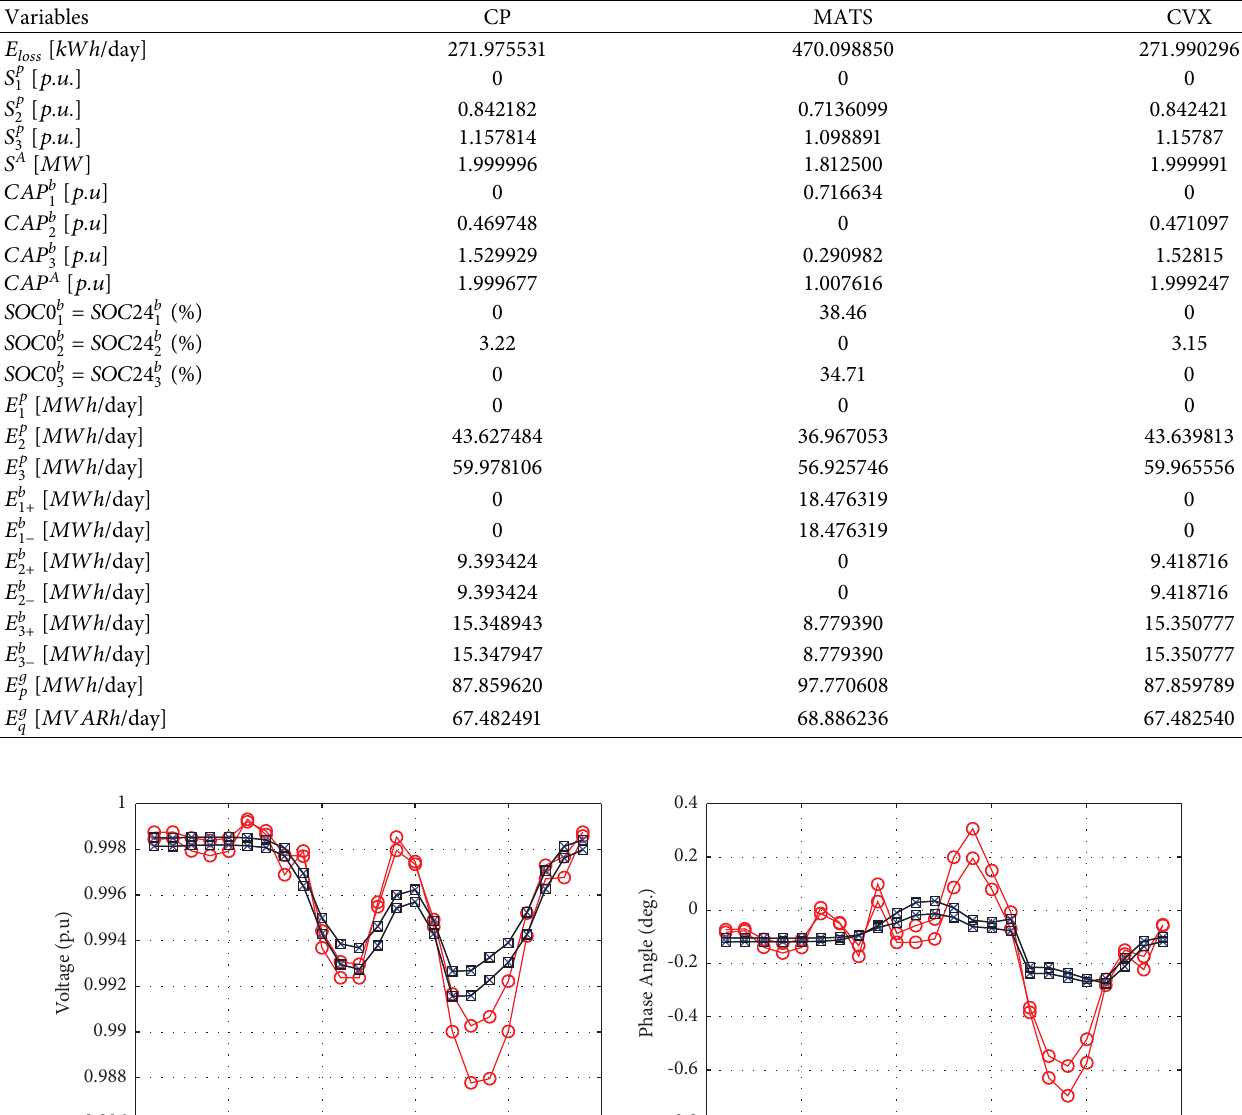
Table 7: Results for simulation 4D.